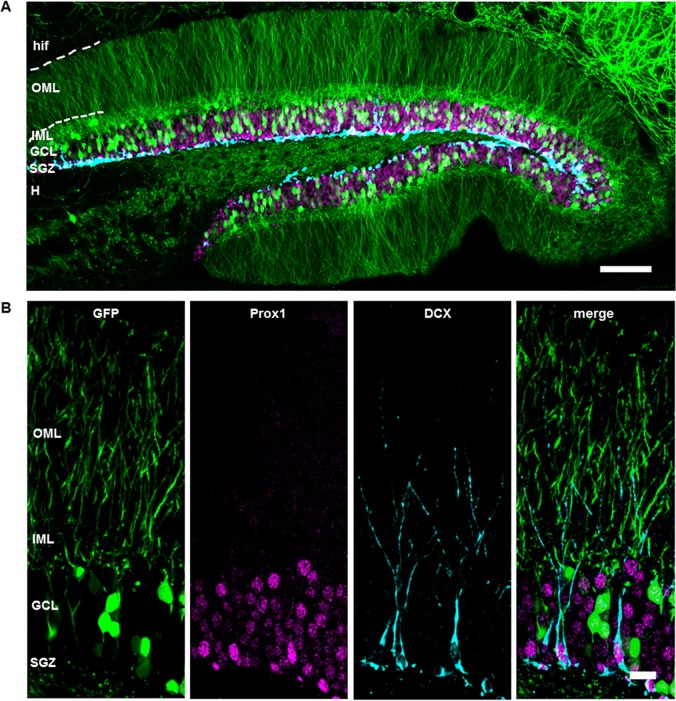
Doublecortin-labeling does not co-localize with Thy1-GFP expression.(A) Frontal section of the dorsal hippocampal formation from a Thy-1-GFP mouse. Thy1-GFP expression was observed in a subpopulation of dentate granule cells (DGCs) and was expressed throughout dendritic processes of DGCs which extend into the inner molecular layer (IML) and outer molecular layer (OML) toward the hippocampal fissure (hif). Prospero homeobox protein 1 (Prox1, magenta), a specific nuclear marker of granule cells, was confined to granule cell nuclei of the granule cell layer (GCL). Doublecortin (DCX, cyan) labeled young maturing cells that are positioned in the subgranular zone (SGZ). (B) There was no co-localization of DCX and Thy1-GFP which suggests that Thy1-GFP is generally expressed in more mature (DCX-) DGCs. Both DCX+ and Thy1-GFP+ granule cells co-localized with Prox1 even during early stages of DCX expression (see small DCX+ cells in the SGZ). Scale bars: (A) 100 μm; (B) 20 μm. CA1, Cornu Ammonis area 1; H, hilus.